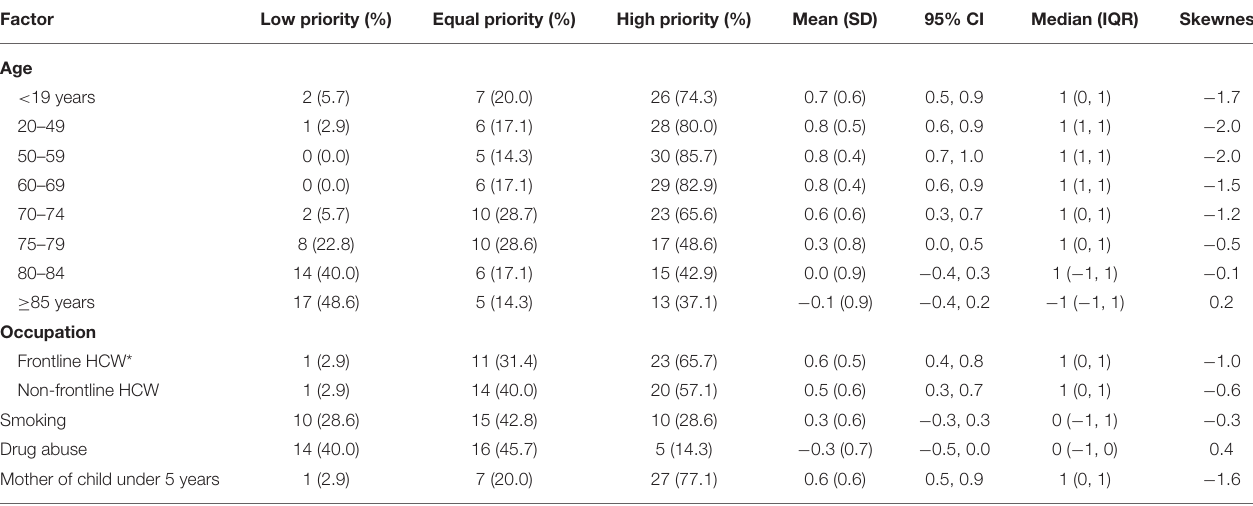
TABLE 2 | Responses on prioritising ventilator allocation regarding non-medical characteristics of patients.